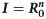
Example trajectories of NB and Poisson branching processes.Figure shows example trajectories (in number of active infections versus generation) of NB and Poisson branching processes and cumulative infection sizes after 6 generations of spread. Both simulations start with 1 infection and have the same R0 = 2.6. For NB branching process, we assume dispersion parameter k = 0.16, same as SARS-CoV-1 [24,33]. We run all simulations 10,000 times. Dashed red lines represent theoretical values in the large-population limit I=R0n, where I is number of active infections, and n is number of generations. Solid blue lines are the mean values of all simulations including those that have not taken off, which overlap with the theoretical values when the susceptibles are not depleted. Solid orange lines are the mean value for simulations that took off, and the outbreaks appear more explosive in the first few generations in the NB simulations. Both number of active cases and cumulative infections are in log10 scale. The code required to generate this figure can be found in S1 Data. NB, negative binomial; SARS-CoV-1, Severe Acute Respiratory Syndrome Coronavirus 1.